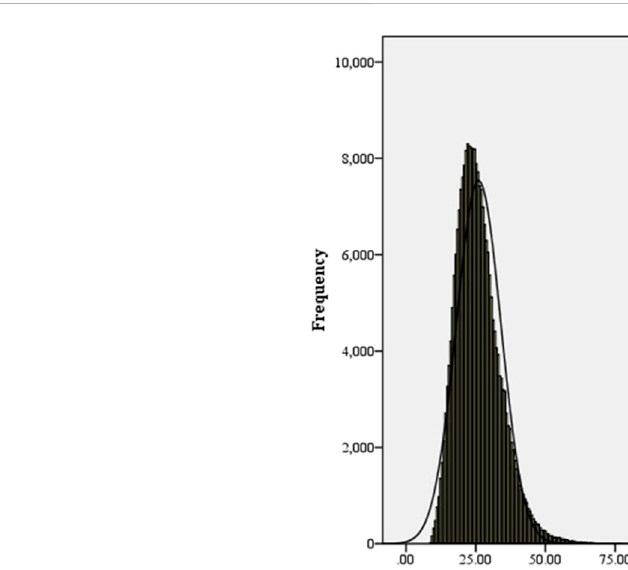
FIGURE 1 Frequency distribution histogram of